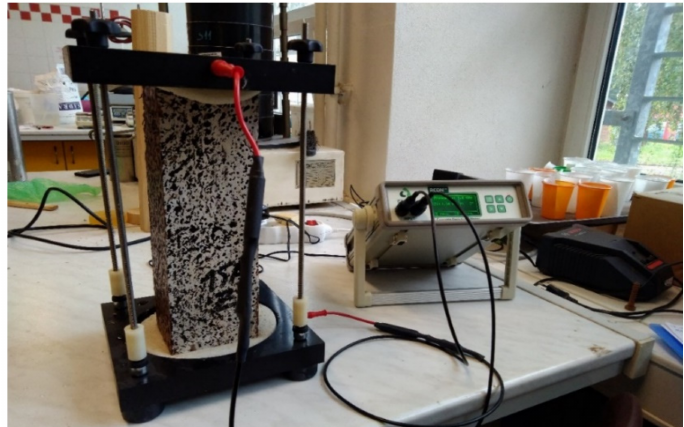
Figure 2. Testing of the bulk resistivity with RCON